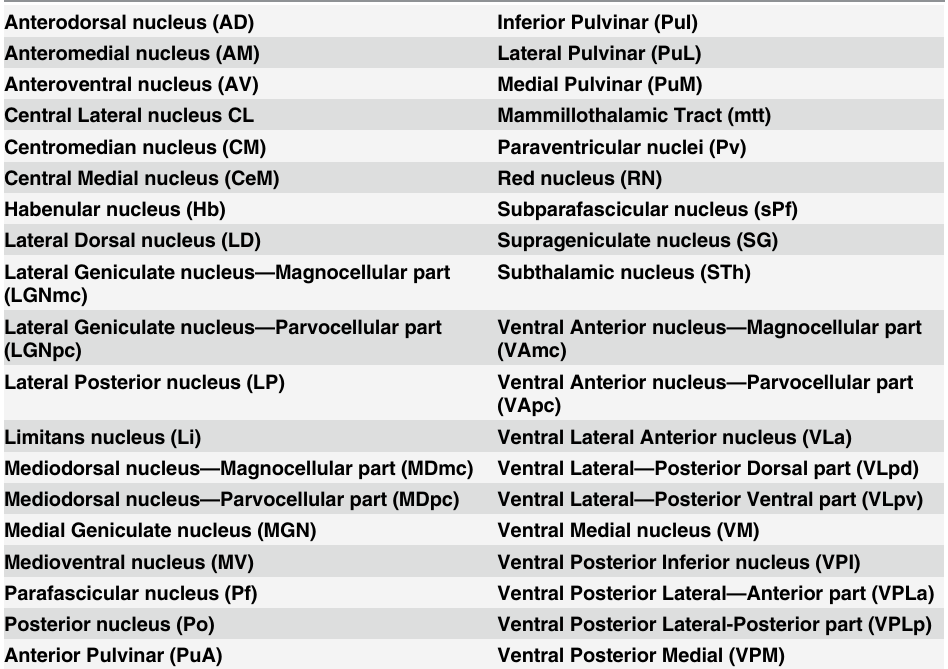
Table 2. Nuclei obtained via atlas-based